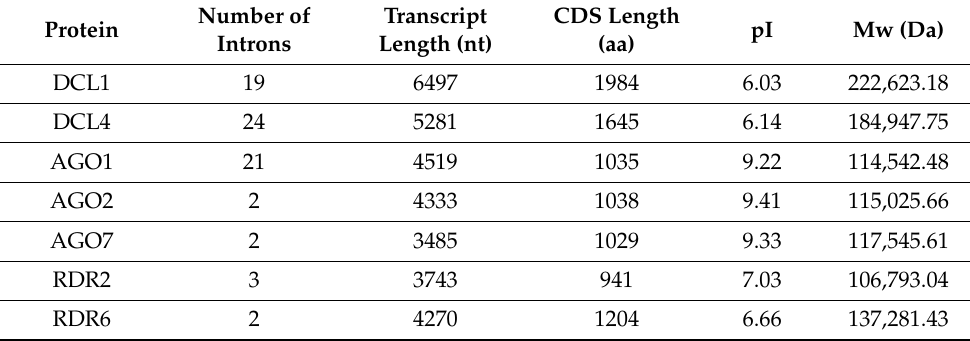
Table 1. Characteristics of core RNAi genes identified in